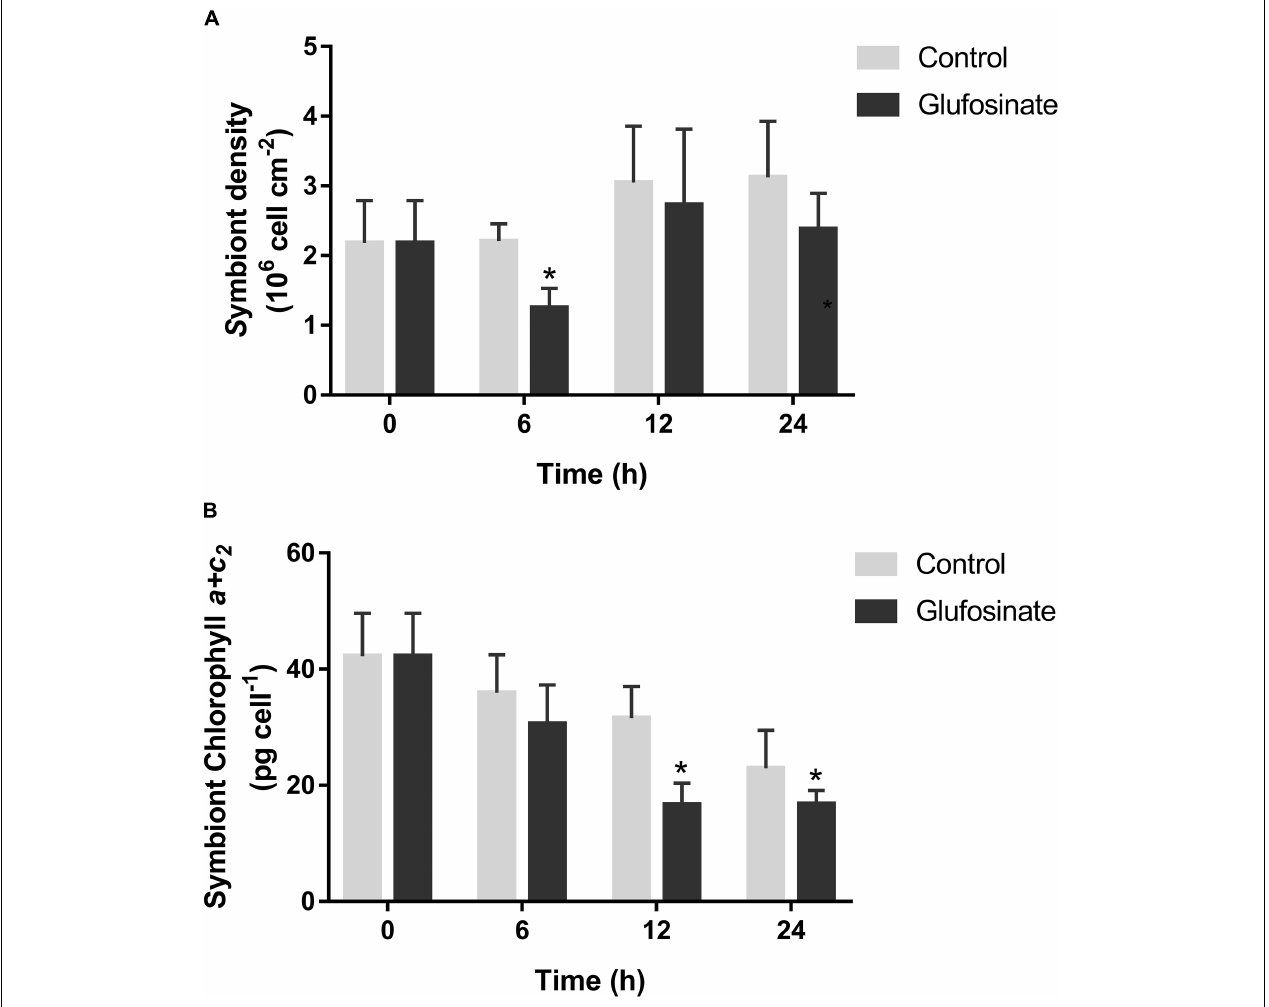
FIGURE 4 | Temporal symbiont density (A) and chlorophyll content (B) in the scleractinian coral Pocillopora damicornis after glufosinate treatment. Data points represent means and error bars represent standard deviations ( N = 6). Asterisks depict significant differences between the glufosinate and control groups ( p <